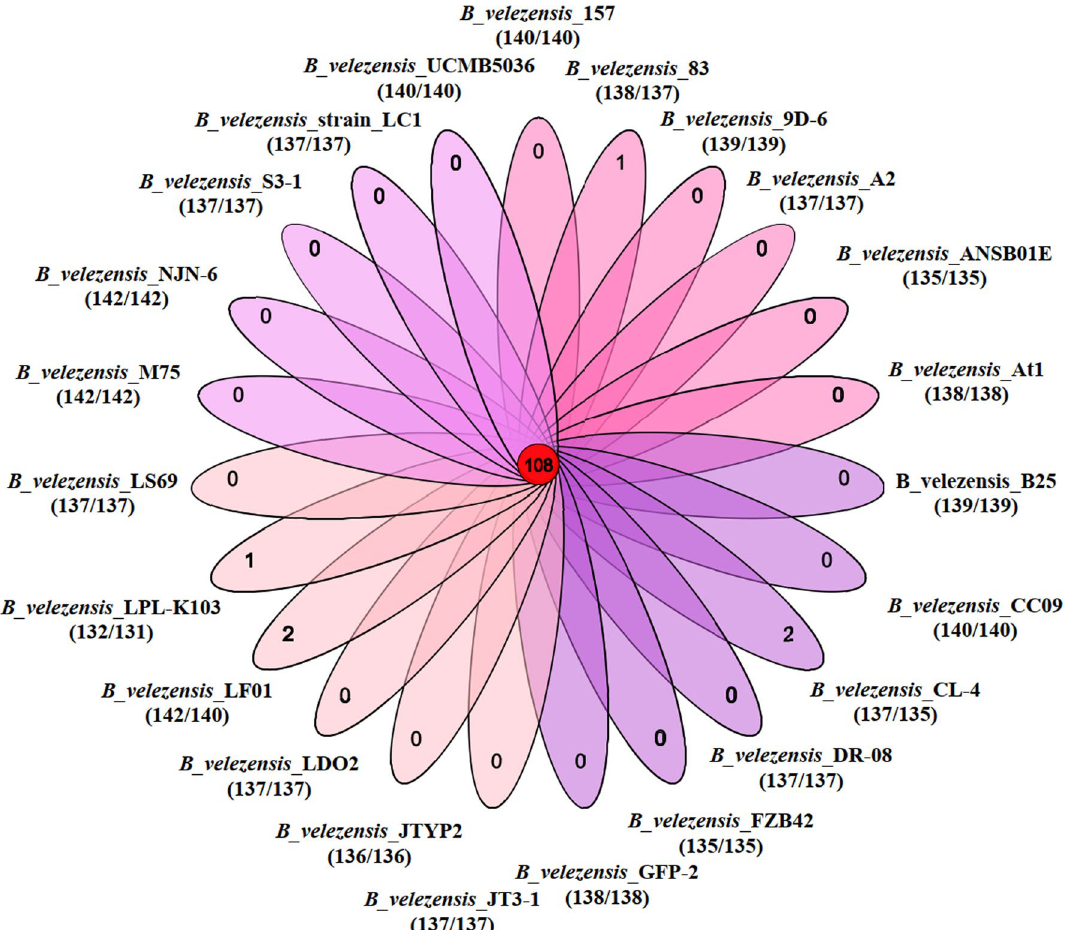
Fig. 1 The total number of genes in each species and genes/gene family were obtained by comparative CAZyme analysis of the twenty-three B. velezensis strains. Side circles represent the total number of genes in a species, and the center circle represents the number of gene families shared by the B. velezensis strains. The total number of genes/gene families shared by a B. velezensis strain is shown in